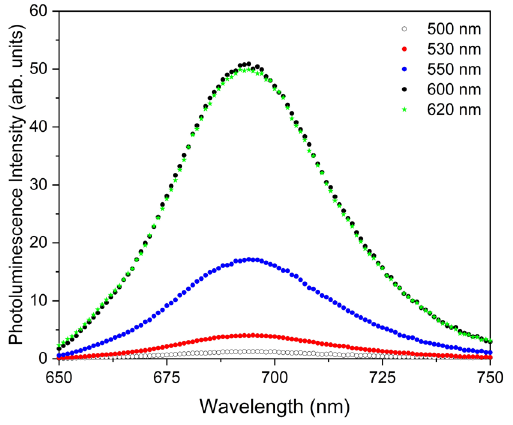
Figure 7. Room temperature photoluminescence spectra of Zn SnO :Co 2+ (0.1%). 2 4